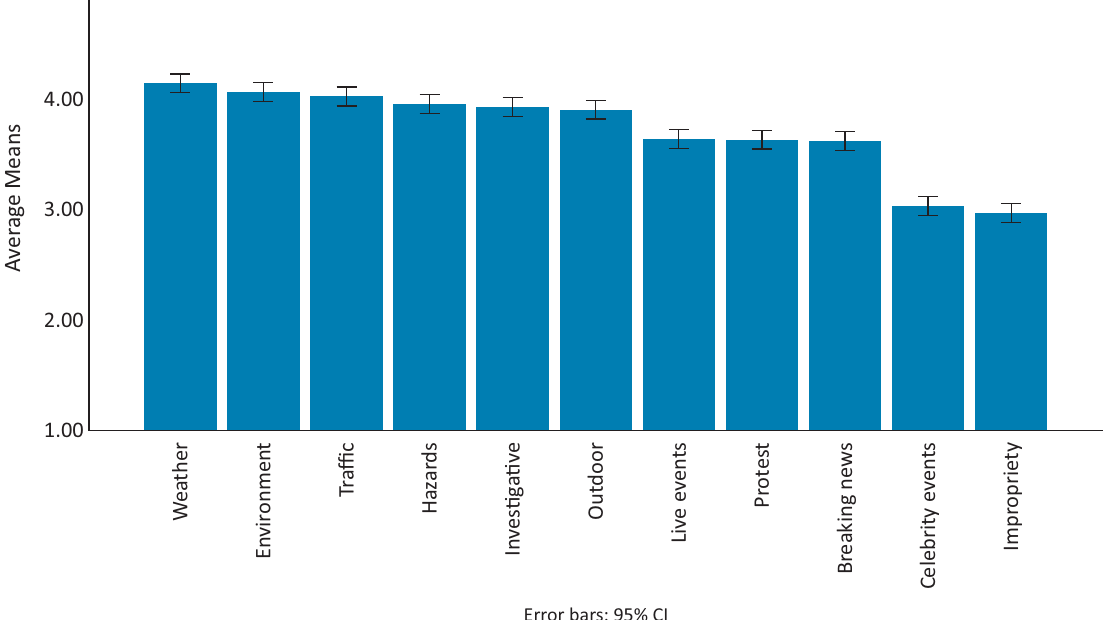
Figure 1. Differences of means of drone story type items. Note: Findings indicate there is significantly more openness toward using UAVs for covering weather, environment and traffic stories than covering celebrity events or